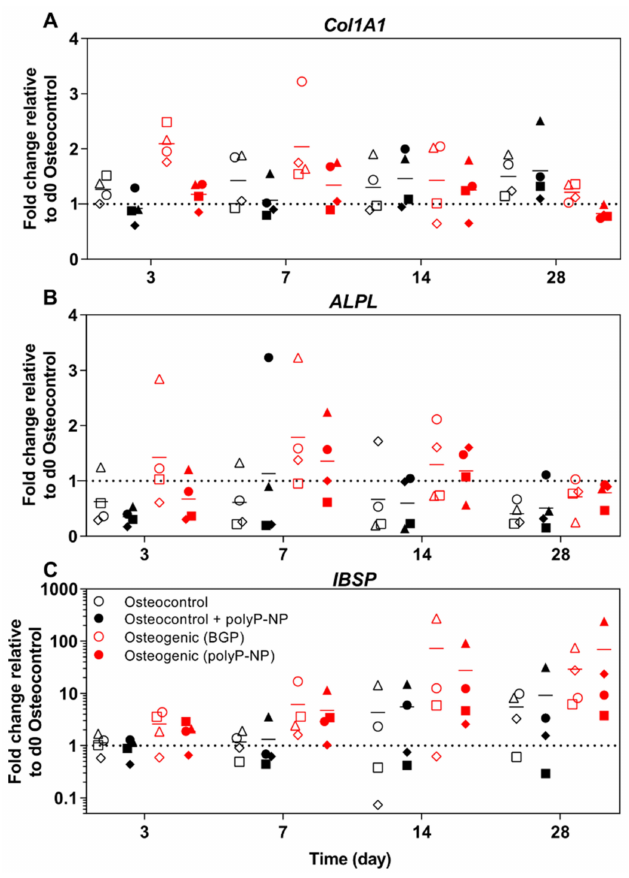
Figure 6. Gene expression of osteogenic markers during di ff erentiation of BM-MSCs. Human BM-MSCs areculturedinosteocontrolmedia ± polyP-NP,orosteogenicmediumcontainingeitherBGPorpolyP-NP, for 28 days. Fold changes in Col1A1 ( A ), ALPL ( B ) and IBSP ( C ) expression at days 3, 7, 14 and 28 are calculated according to the ∆∆ C t method using RPLP0 as the endogenous calibrator and the osteocontrol at day 0 as the normaliser. Individual data points shown are the mean of two technical replicates for each individual donor: donor A ( (cid:3) ), donor B ( ∆ ), donor C ( ♦ ) and donor D (o). The mean of the four independent donors within each group is indicated by the horizontal